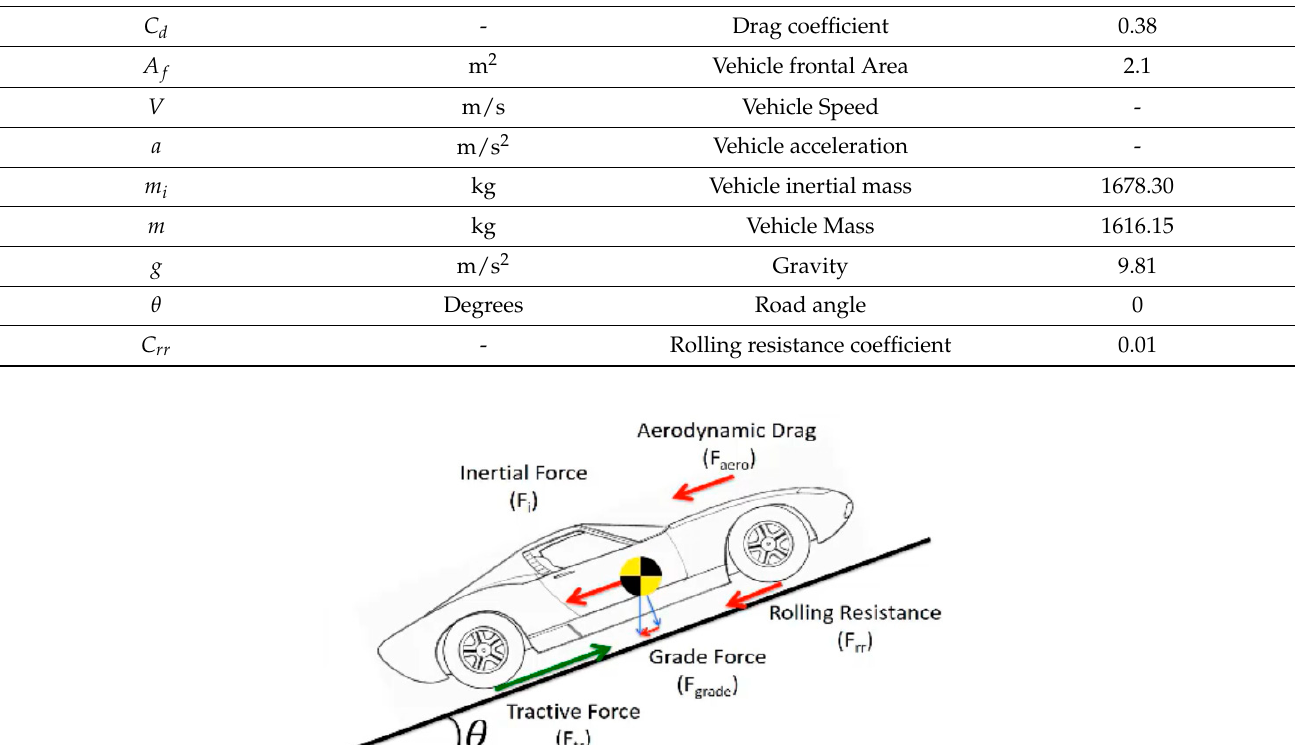
Table 2. Glider Model Parameters Adapted from [16], MathWorks: 2020.